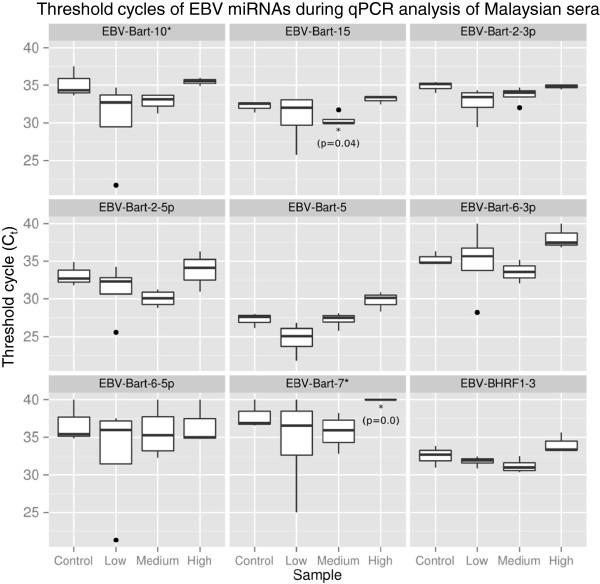
Box and whisker plots of EBV miRNA expression levels in Malaysian sera determined using qPCR. Box and whisker plots of the threshold cycle (Ct) values are shown for all miRNAs according to anti-viral capsid antigen (VCA) IgG titers. Low – IgG titers between 40–160; Medium – IgG titers between 320–640; and High – IgG titers greater than 640. Boxes encompass the range between the upper and lower quartiles and whiskers extend to high/lowest values outside these bounds. Outliers, defined as greater/less than the upper/lower quartile by more than 1.5 times the interquartile range, are plotted as points. Significantly dysregulated miRNAs are highlighted with asterisks.